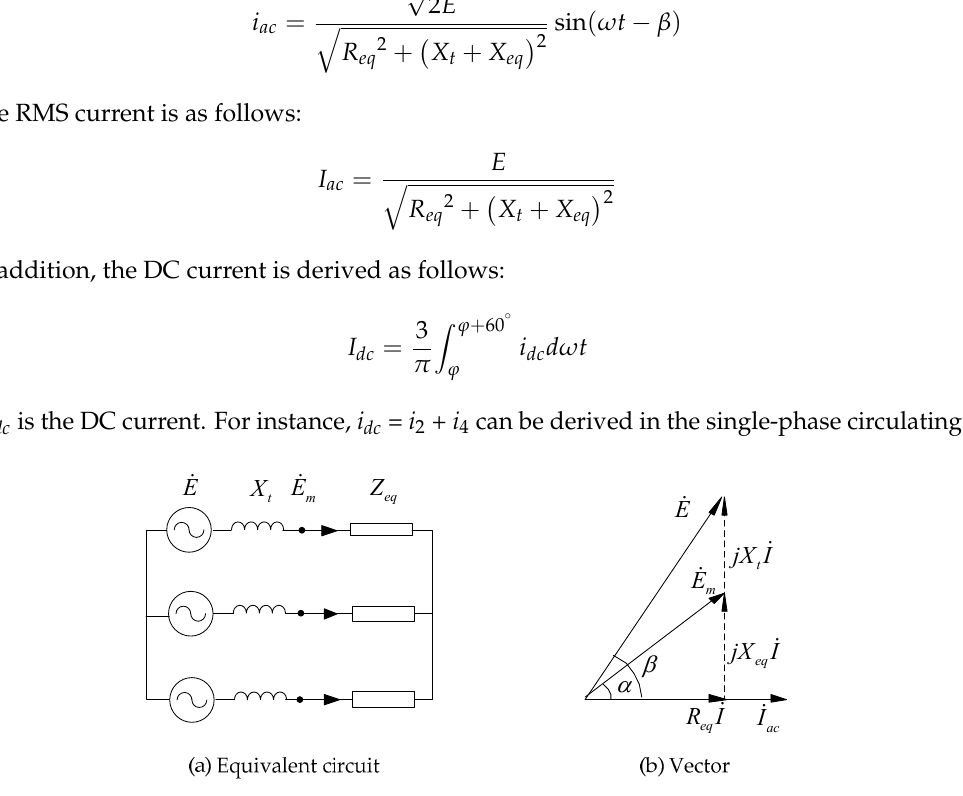
Figure 9. Equivalent circuit and vector diagram. ( a ) Equivalent circuit; ( b ) Vector.